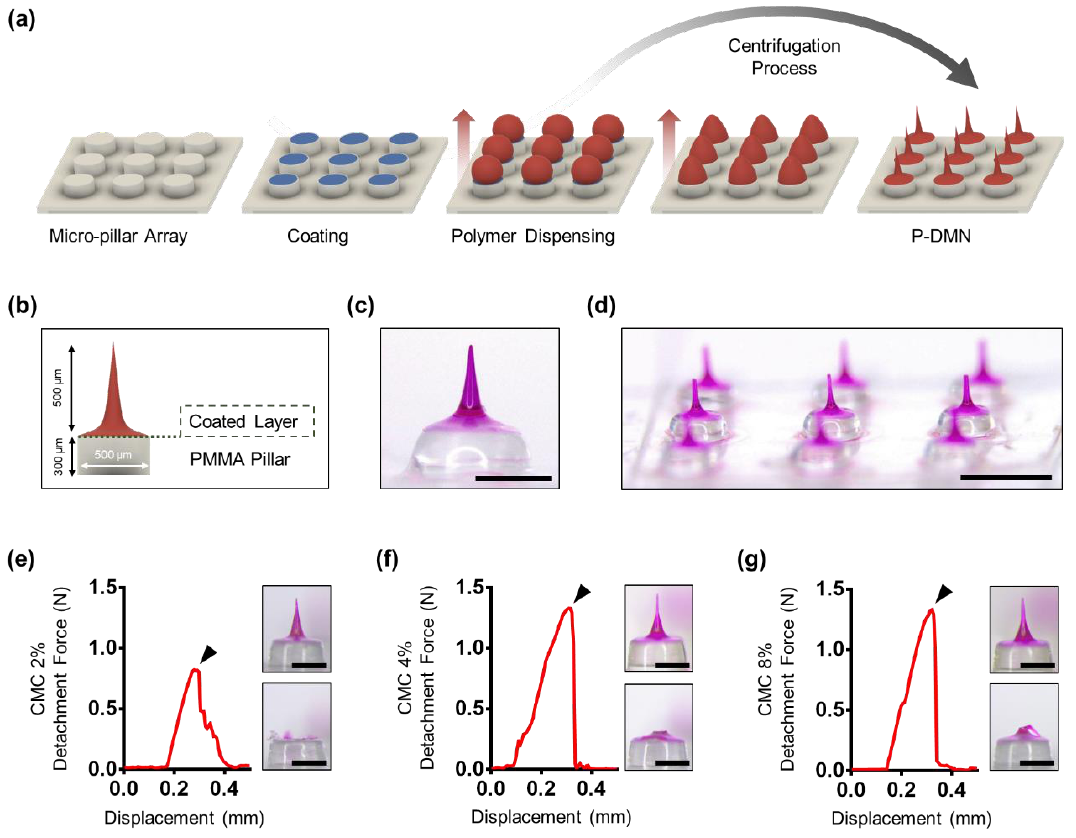
Figure 1. Fabrication of micro-pillar integrated dissolving microneedles (P-DMNs). ( a ) Schematic illustration of the P-DMN fabrication process. First, the micro-pillar array is arranged with a layer of coating. Next, the drug surrogate-encapsulated polymer mixture is dispensed over the micro-pillars, followed by centrifugation to form P-DMNs with a sharp tip. Red arrows indicate the direction of centrifugal force applied to dispensed polymers. ( b ) A P-DMN consists of three layers: a polymethyl methacrylate (PMMA) pillar, a carboxymethylcellulose (CMC) layer, and a dissolving microneedle (DMN). Bright-field microscopy image of ( c ) a single and ( d ) a 3 × 3 array of P-DMNs. ( e – g ) Force required to separate a P-DMN fabricated with 2%, 4%, and 8% CMC. Bright-field microscopy images on the right panels show P-DMNs prior to and post-evaluation. Arrows indicate the detachment point from micro-pillars. Scale bars in (c), (e), (f), and (g) are 300 μm, and 1 mm in (d).